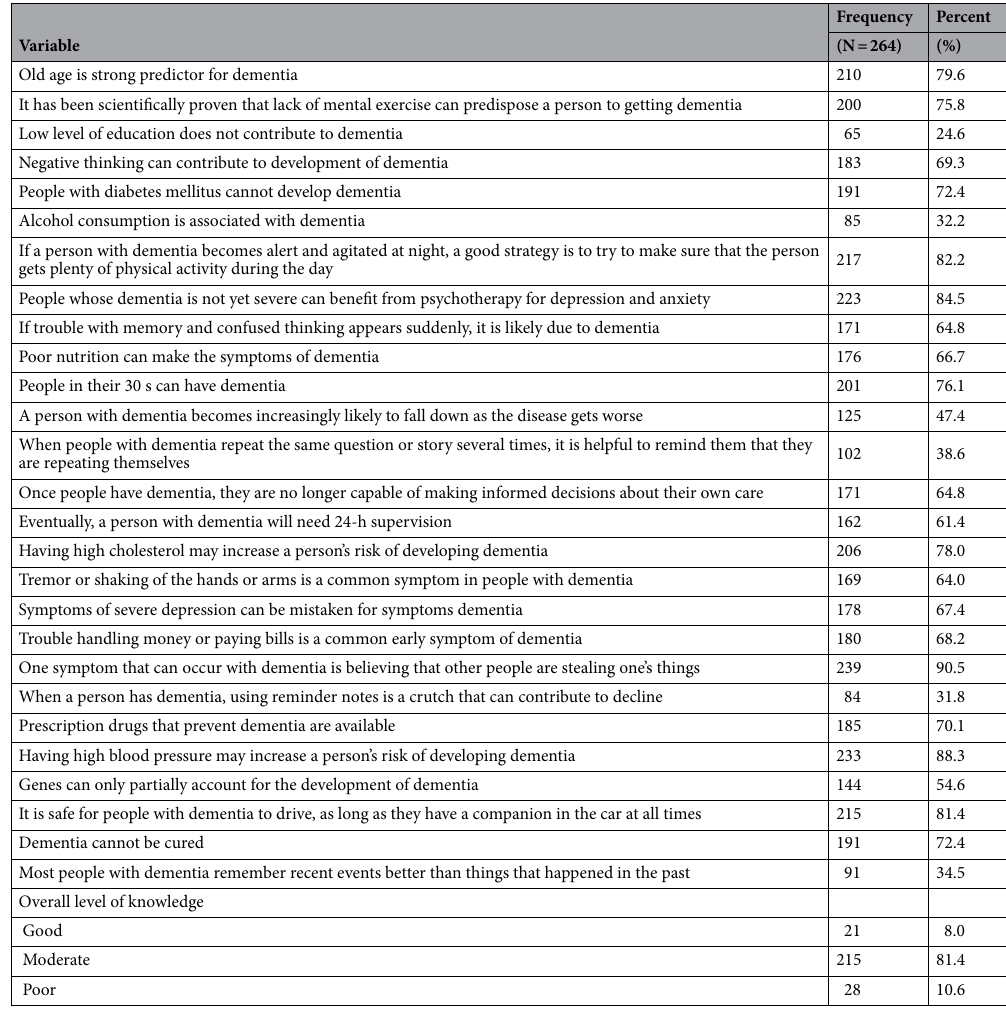
Table 5. Knowledge of